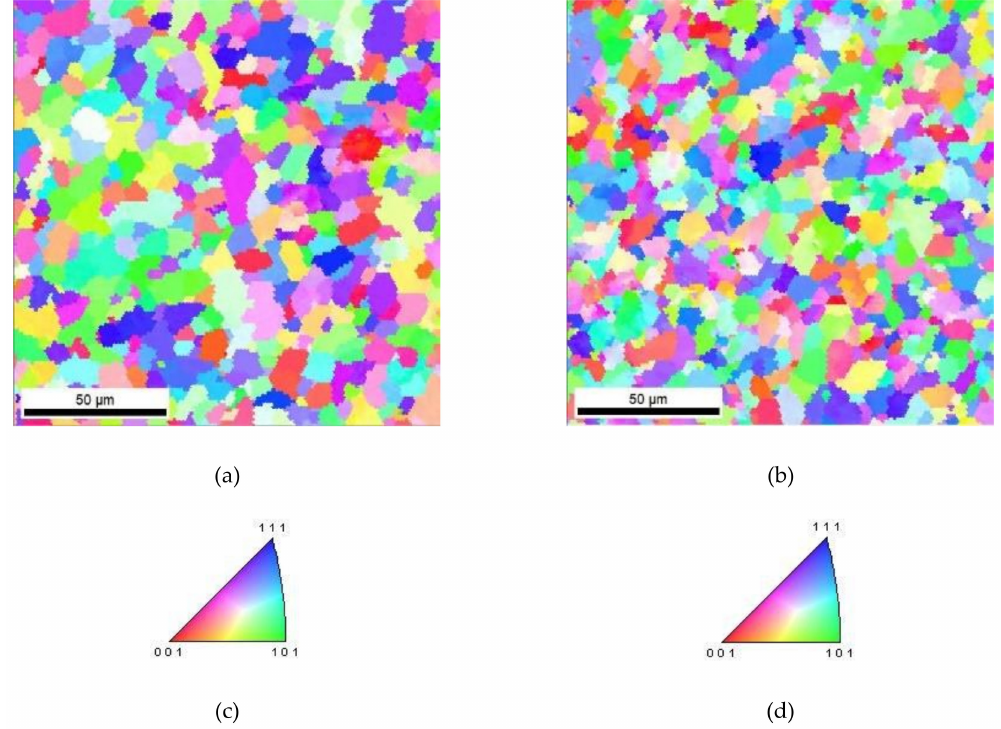
Figure 7. The inverse pole figures (IPF) of the ( a ) pure Al and ( b ) Al-Graphene, and their corresponding coded maps, respectively, ( c ) and ( d )